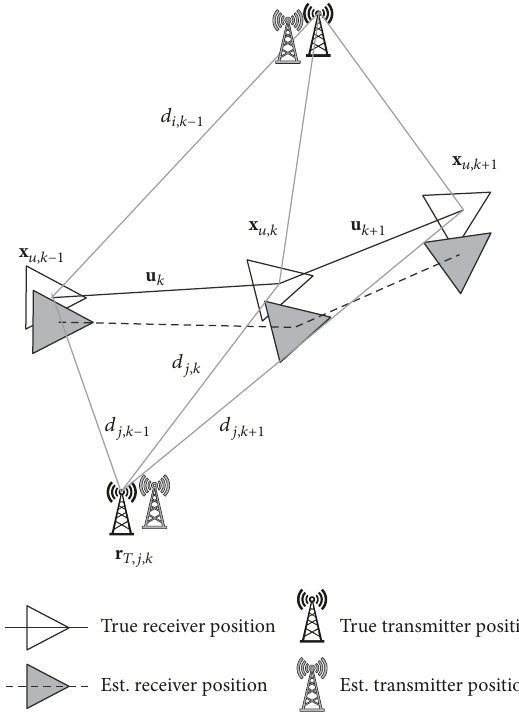
Figure 5: Overview of the SLAM example: the moving receiver simultaneously estimates its position and the location of the trans-